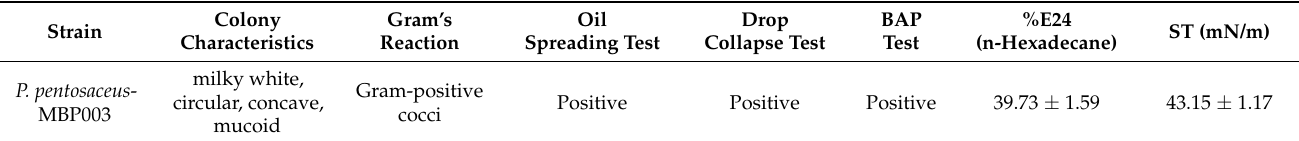
Table 1. Qualitative and quantitative results of the different screening assays for the production of a cell-free biosurfactant (values are representatives of mean ± S.D ( n =